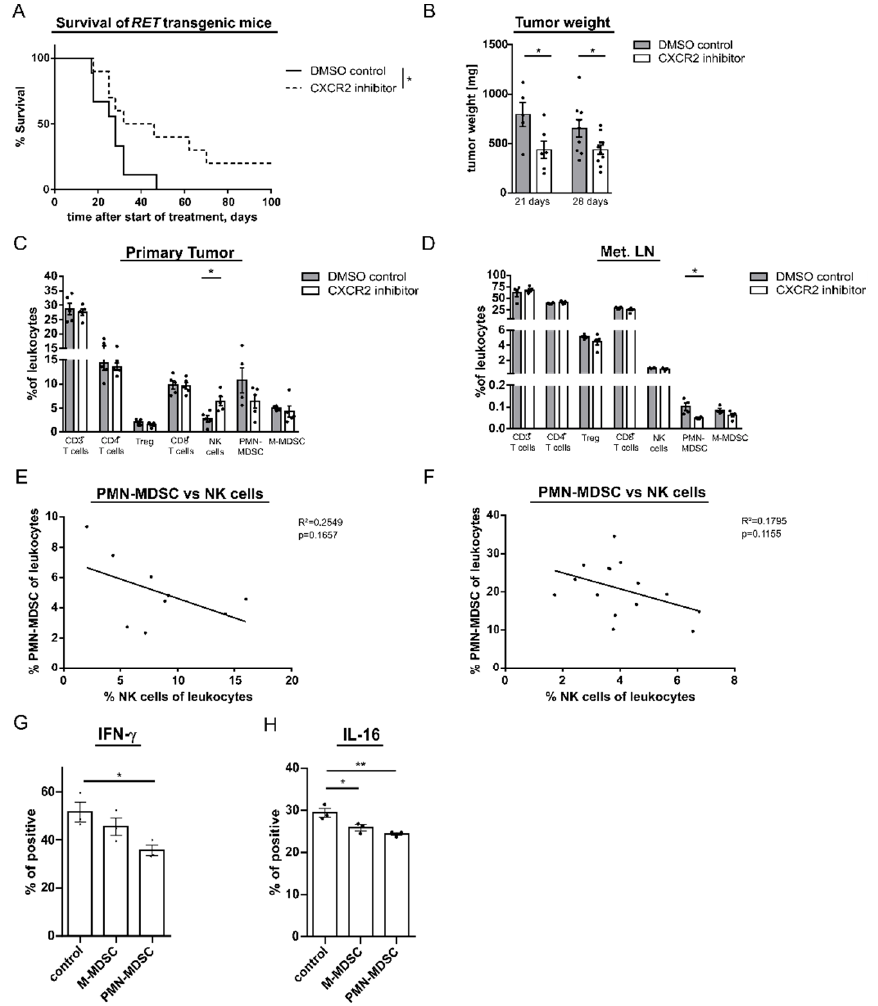
Figure 5. Effect of anti-CXCR2 therapy on mouse survival and on tumor infiltrating immune cells. RET transgenic mela- noma bearing mice were injected i.p. with the CXCR2 inhibitor SB265610 (2 mg/kg) or the control DMSO solution (control group) twice a week for four weeks. ( A ) Survival of mice (9–10 mice/group) is shown as a Kaplan – Meier curve. ( B ) Weight of tumors from mice treated with SB265610 or the control injection was measured at day 21 and 28 after the treatment initiation in two independent experiments. Results are shown in mg. One day after the last injection, cells infiltrating primary skin tumors ( C ) and metastatic LN ( D ) were measured by flow cytometry. Data are presented as the percentage of CD3 + , CD4 + and CD8 + T cells, CD4 + CD25 + FoxP3 + Treg, CD3 - NK1.1 + NK cells, PMN- and M-MDSC within CD45 + leuko- cytes (mean ± SEM; 4–5 mice/group). The percentage of PMN-MDSC among CD45 + leukocytes infiltrating primary mela- noma ( E ) or mesothelioma ( F ) were plotted against the percentage of tumor infiltrating NK cells within CD45 + leukocytes from respective mice ( n = 9–15). The correlation was evaluated by a linear regression analysis. Mouse NK cells were cul- tured with in vitro differentiated PMN- or M-MDSC at a ratio of 1:2. Frequency of IFN- γ ( G ) or IL-16 producing NK cells ( H ) was determined by flow cytometry after 4 h of coculture. NK cells cultured alone (control) served as a negative control. Data are shown as the percentage of IFN- γ + or IL-16 + NK cells within total NK cells (mean ± SEM; n = 3). * p < 0.05, ** p < 0.01.